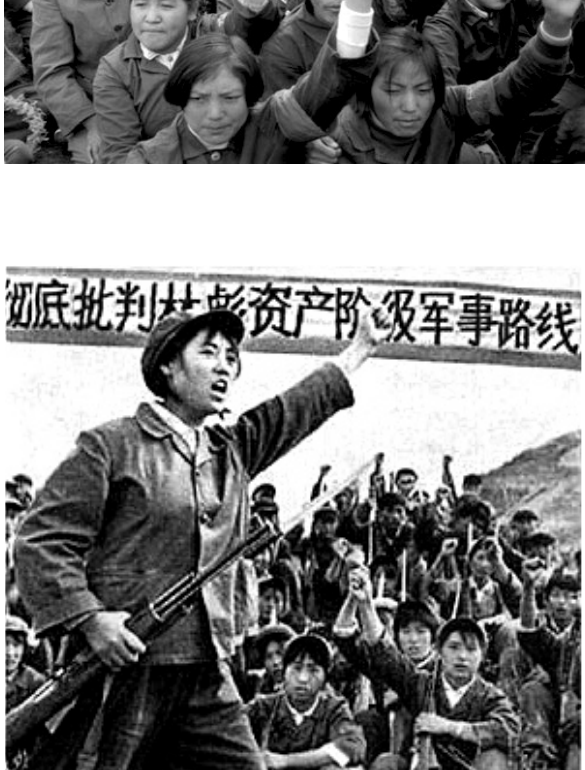
Fig.1-2: Cultural Revolution-style clothing from the early 1970s. Photo: